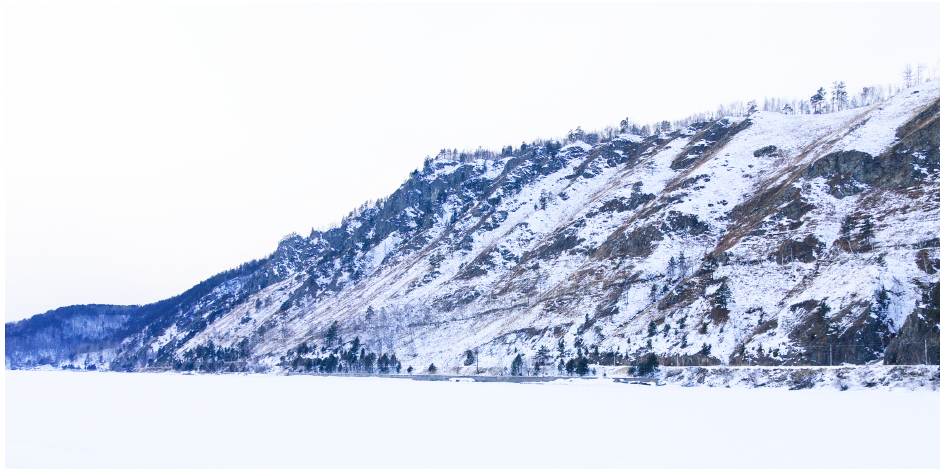
Figure 13. View on the shoreline section ‘observed’ by the detector from the position indicated on Figure 14 is in the middle of the